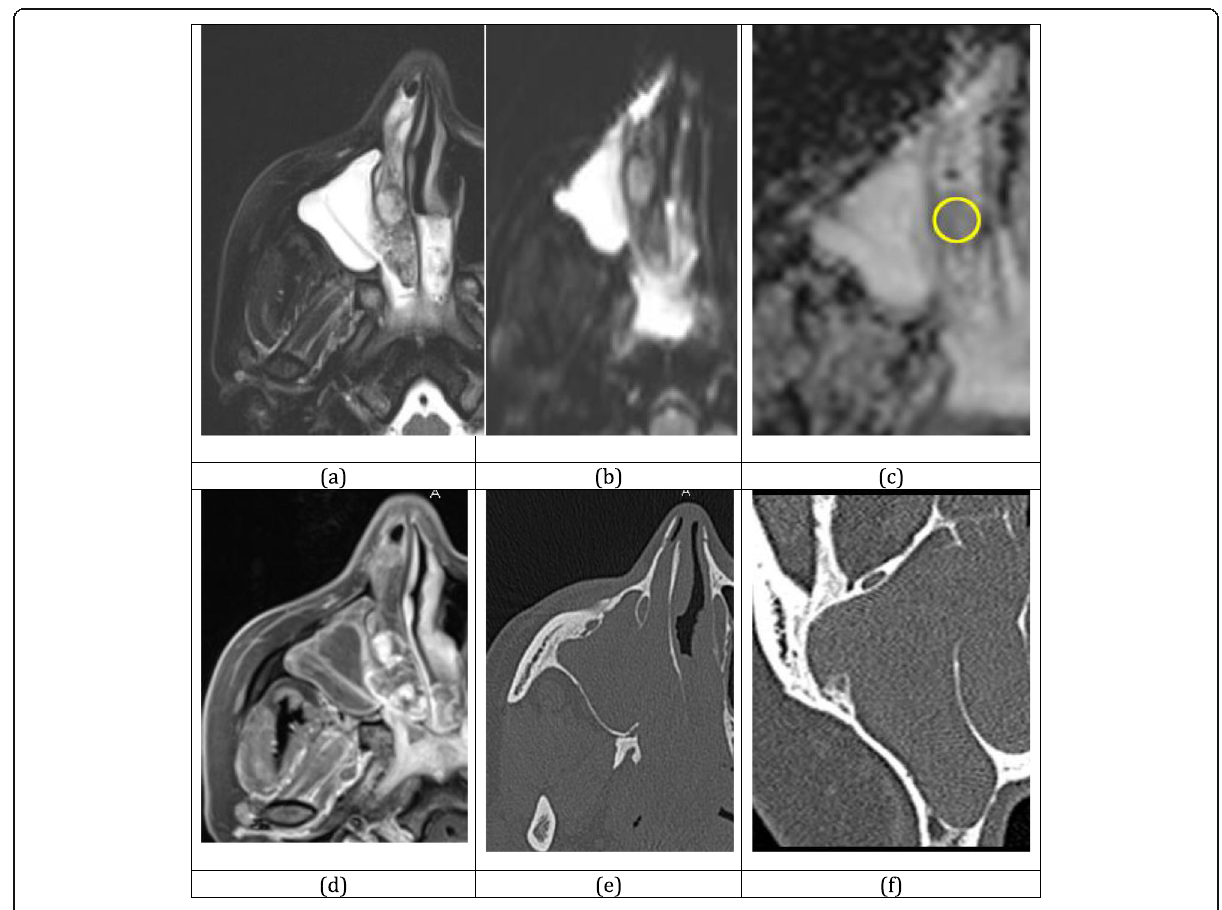
Fig. 2 A 45-year-old woman with unilateral nasal obstruction and proven nasal inverted papilloma. Axial T2-weighted fat suppression image ( a ) reveals convoluted type of striated pattern. A cystic lesion is seen not considered to interrupt the imaging signature and likely corresponds to histopathology finding of mucus retention cyst lined by glandular epithelium of the tumor. Axial diffusion and apparent diffusion co-efficient maps in ( b ) and ( c ), respectively, show average apparent diffusion co-efficient values of 1.5 × 10 -3 cm 2 /s. Axial post- gadolinium-enhanced exam reveals nodular pattern of enhancement corresponding to enhanced glands of the retention cysts. Axial computed tomography ( e ) reveals smooth mass effect and mild rarefaction of posterior bony nasal septum and medial maxillary wall. Coronal computed tomography image ( f ) displaying focal cone-shaped hyperostosis with complete obstruction of the ostio-meatal